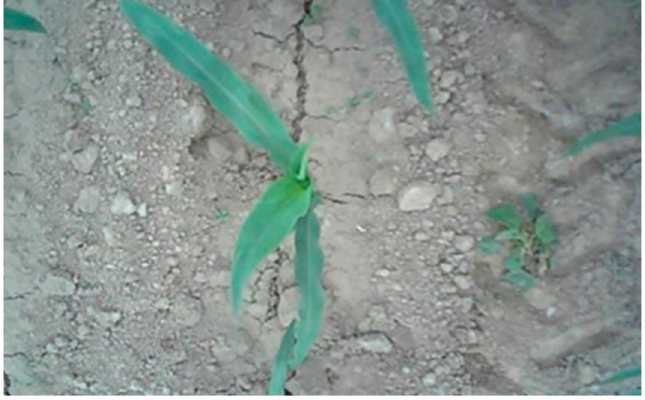
Figure 3. Images taken on cloudy days.